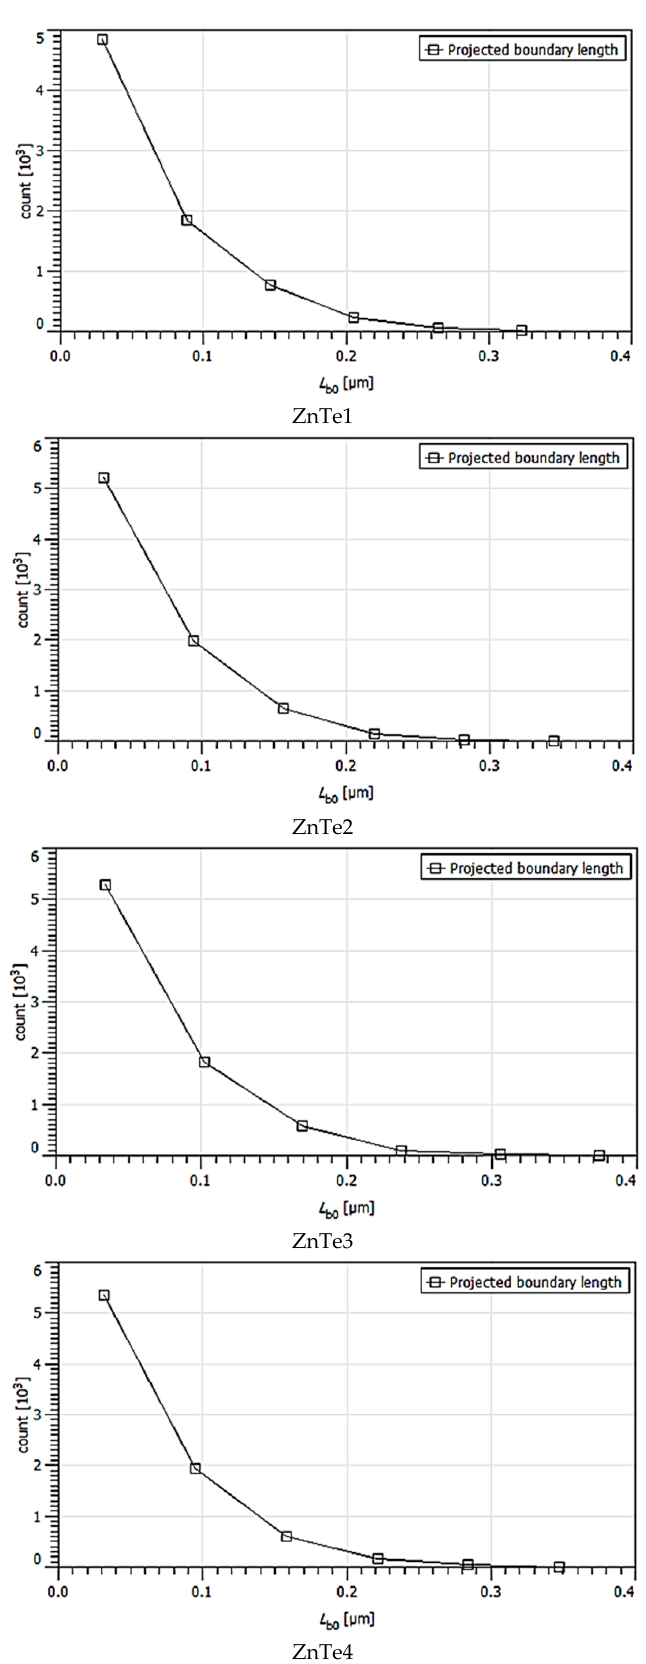
Figure 7. Projected boundary length statistic variation of ZnTe1,2,3,4 thin